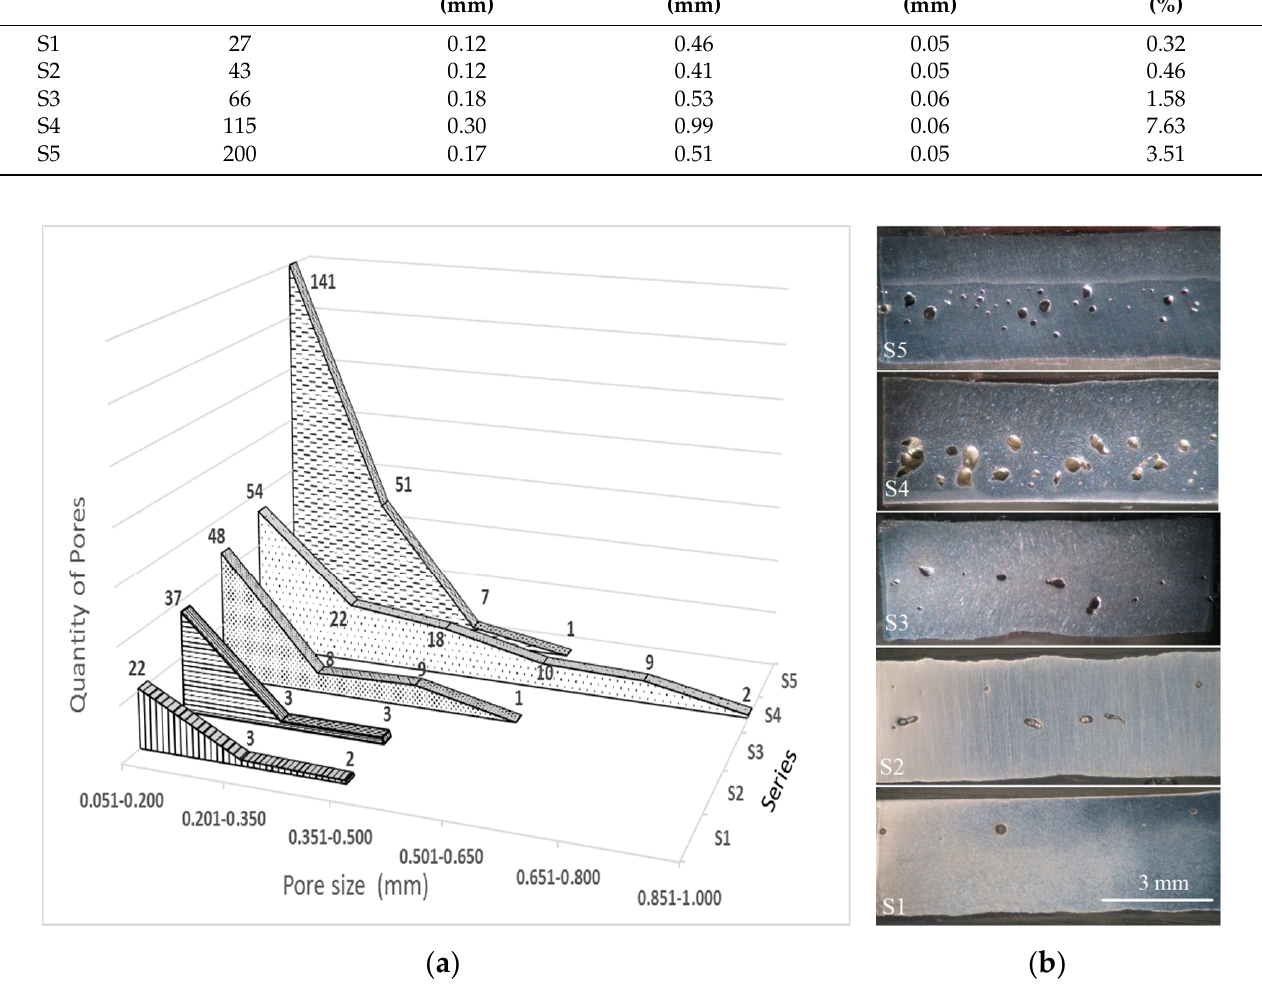
Figure 5. Distribution ( a ) and appearance ( b ) of porosity for the welded series.